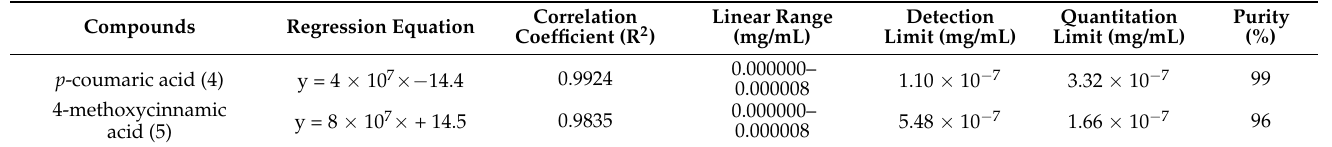
Table 2. Validation data from calibration curves of compounds ( 4 ) and ( 5